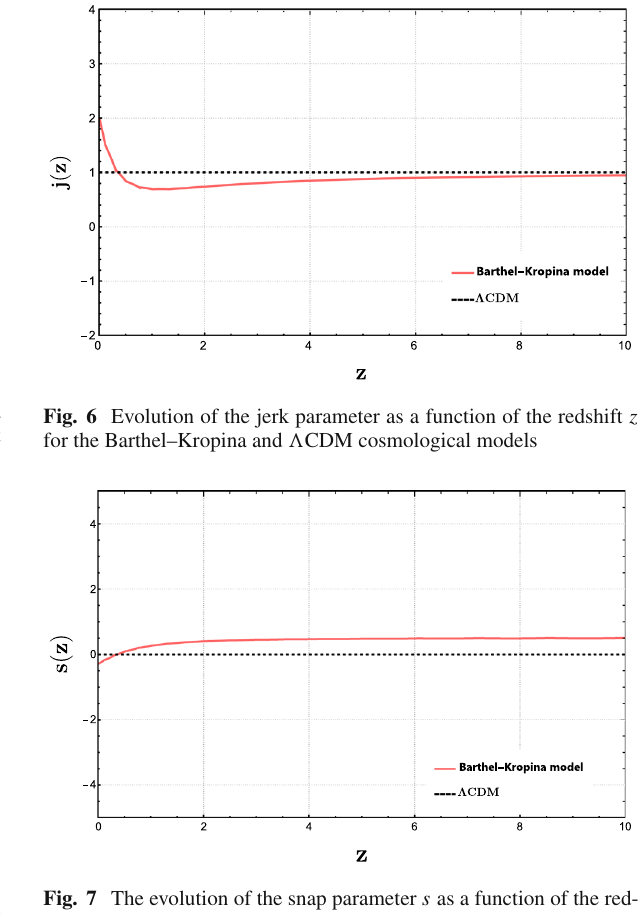
Fig. 5 Evolution of the deceleration parameter as a function of the redshift z for the Barthel–Kropina and (cid:2) CDM cosmologies